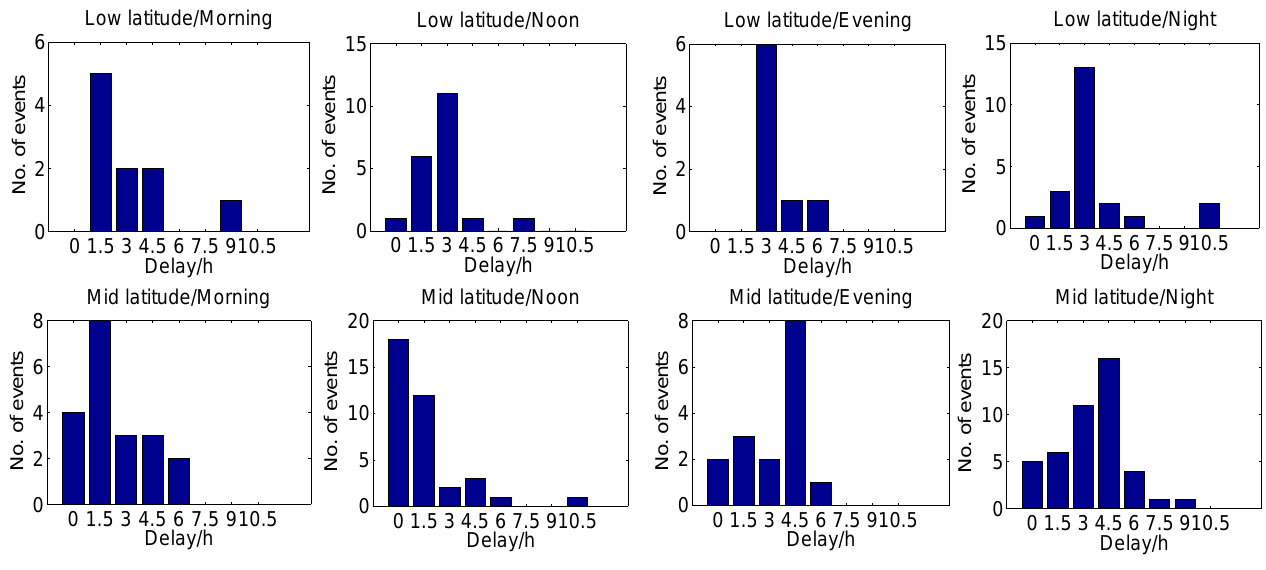
Fig. 6. The delayed response of density at 400km behind E m for low (top) and mid (bottom) latitude during 30 geomagnetic storms between 2002 to 2005. The four columns show respectively the delay times of density at mid latitudes for morning, noon, evening and night sectors, where the morning sector represents 05:00 to 09:00MLT, the noon sector 10:00 to 16:00MLT, the evening sector 17:00 to 20:00MLT, and the night sector 21:00 to